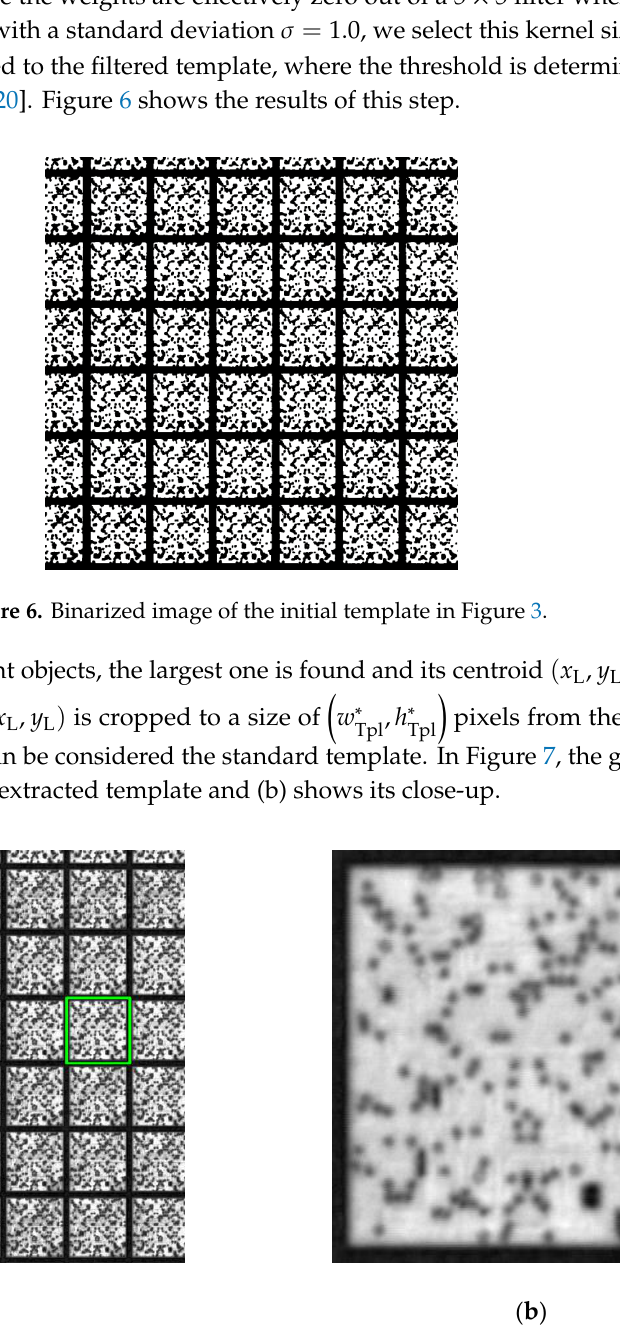
Figure 7. Patches: ( a ) extracted from the initial template; ( b ) used as a standard template.